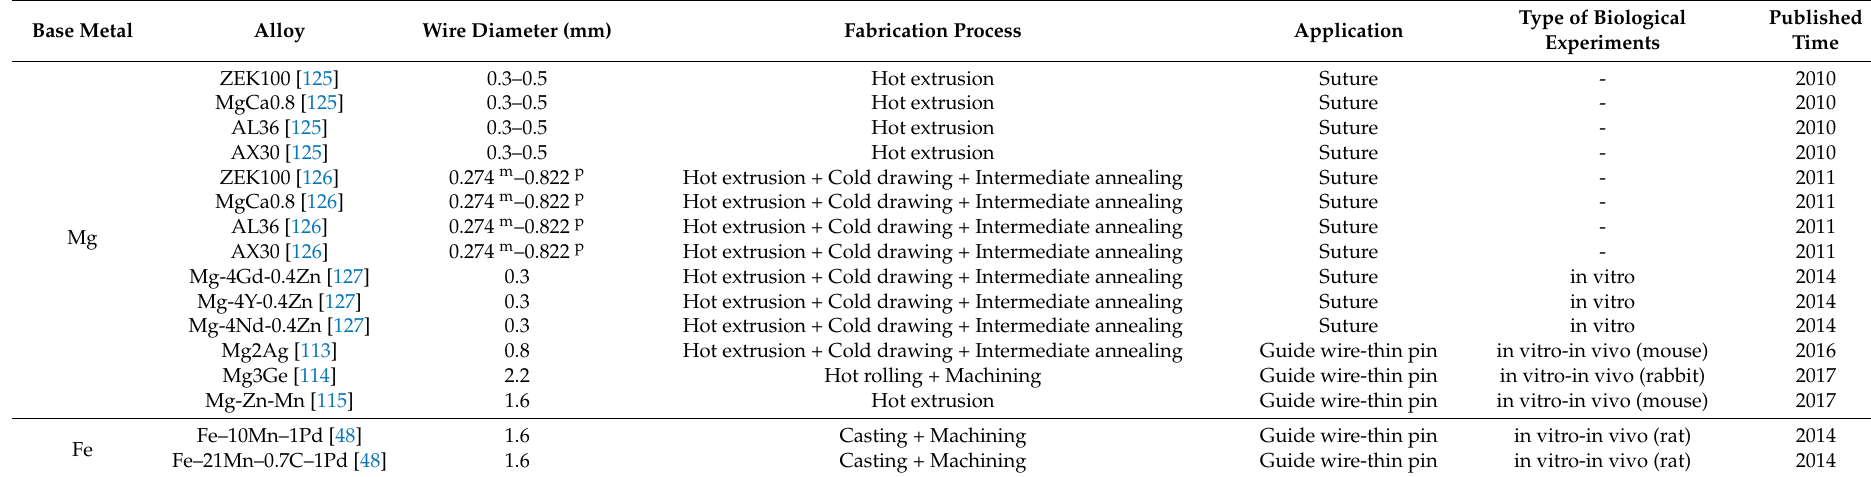
Table 3. Biodegradable metallic wires in bone